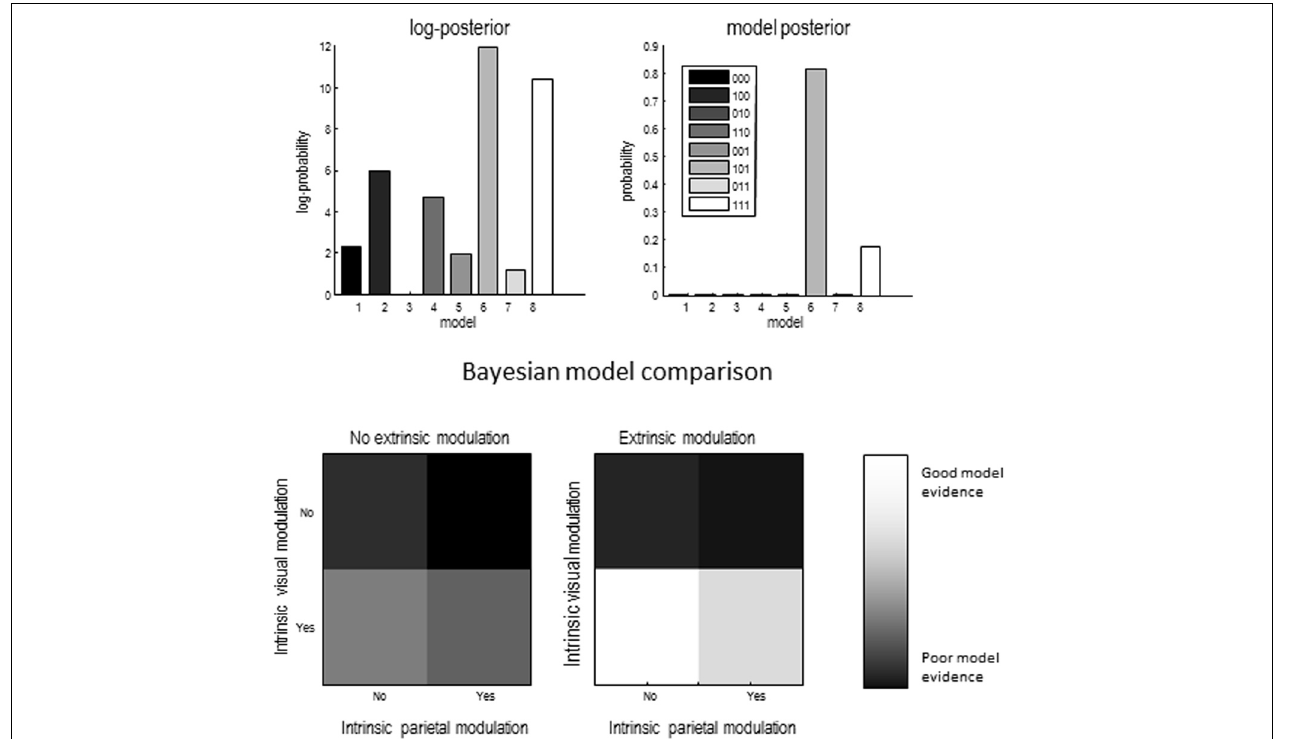
FIGURE 7 | Upper left panel: relative log evidence for models which fitted differences between conditions through changes in one of three sets of parameters: superficial pyramidal cell gain in visual areas (1 _ _), superficial pyramidal cell gain in parietal areas (_ 1 _) and strength of backwards modulatory connections (_ _ 1). Upper right panel: The winning model had changes in superficial